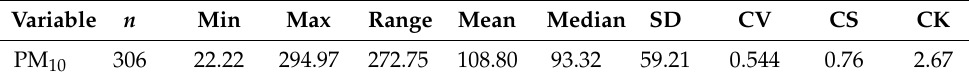
Table 4. Descriptive statistics for PM 10 recorded for the HCH monitoring station (CEM